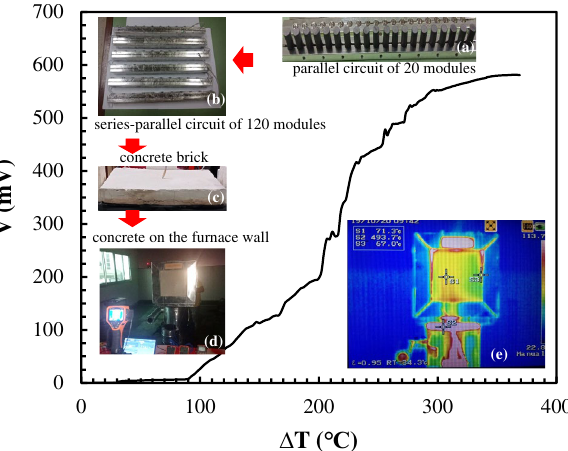
Figure 14. Output voltage of the 120 unileg CaMnO 3 TEG modules in a concrete brick with embedded on a side wall of the high temperature